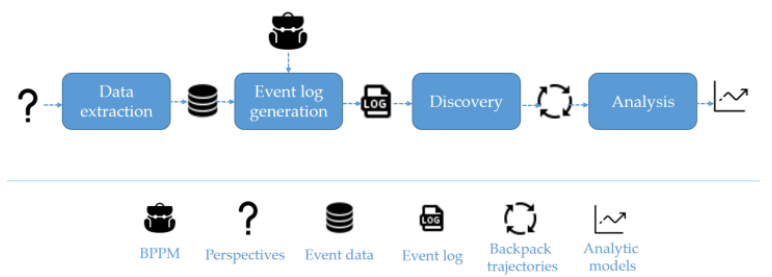
Figure 2. Stages for the generation of the process model, based on an adapted version of PM 2 methodology [35].